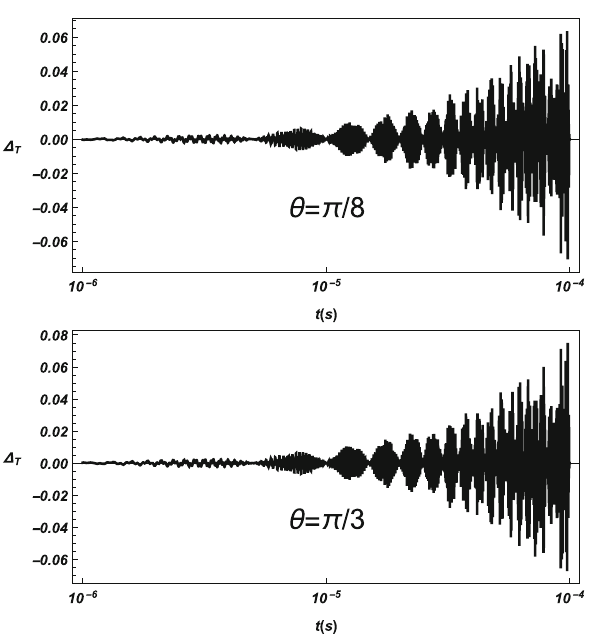
Fig. 4 Plots of (cid:14) T ( t ) for different choices of θ for a set-up with n = 4 trapped ions, and the same parameters as Fig. 3. Here we use a different time scale in order to better highlight the T